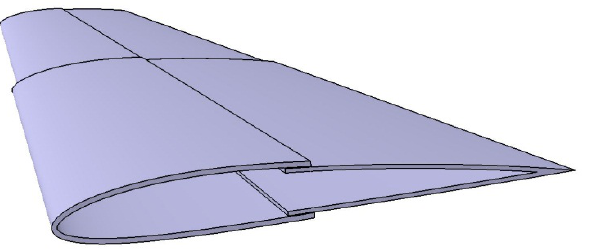
Figure 1. Sliding skin with backward-facing steps on both sides of the wing.